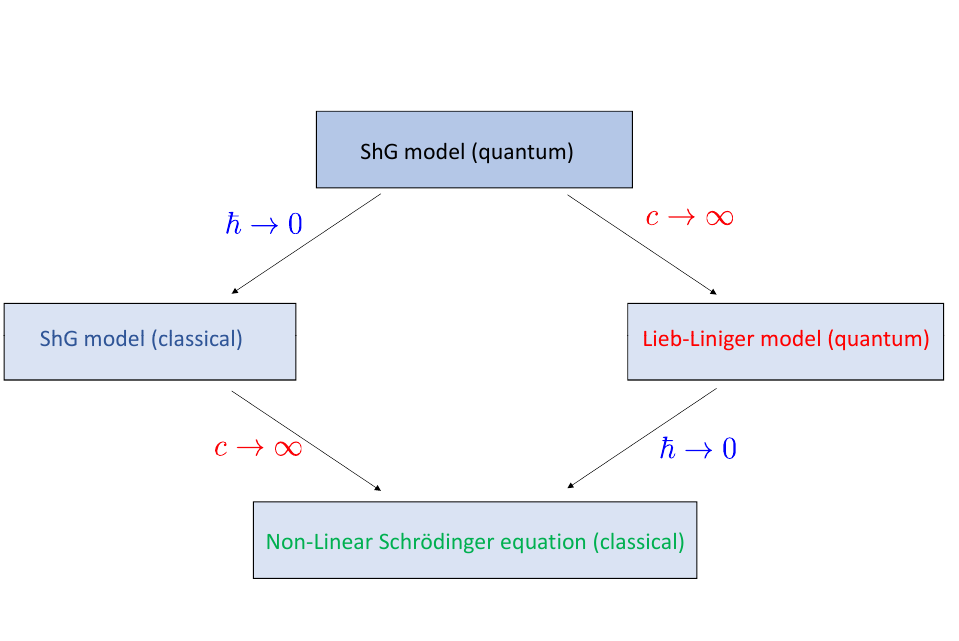
Figure 1: Mapping of the various theories related to the quantum field theory of the sinh-Gordon